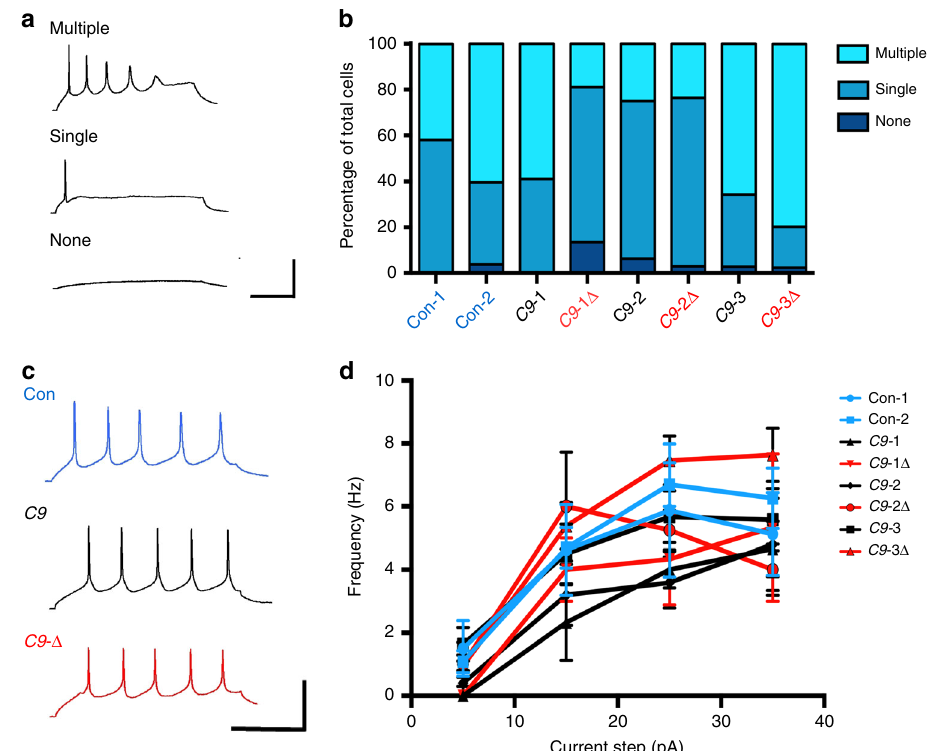
Fig. 3 Excitability of MNs derived from mutant C9ORF72 patient and control iPSCs. a Evoked fi ring types observed in iPSC-derived MNs. MNs displayed either multiple, single, or no action potentials upon current stimulation. b Percentage of cells showing each category of fi ring did not differ between MNs derived from control (Con-1, n = 31; Con-2, n = 53), C9ORF72 mutant (C9-1, n = 17; C9-2, n = 32; C9-3, n = 73), and gene-edited (C9-1 Δ , n = 37; C9-2 Δ , n = 34; C9-3 Δ , n = 84) iPSC lines. c Raw traces showing repetitive action potential fi ring ( > 5 action potentials) in response to current injection in MNs derived from control, C9ORF72 mutant, and gene-edited iPSC lines. d F – I relationships generated from repetitively fi ring MNs reveal no signi fi cant differences between MNs derived from control (Con-1, n = 8; Con-2, n = 23), C9ORF72 mutant (C9-1, n = 3; C9-2, n = 5; C9-3, n = 22), and